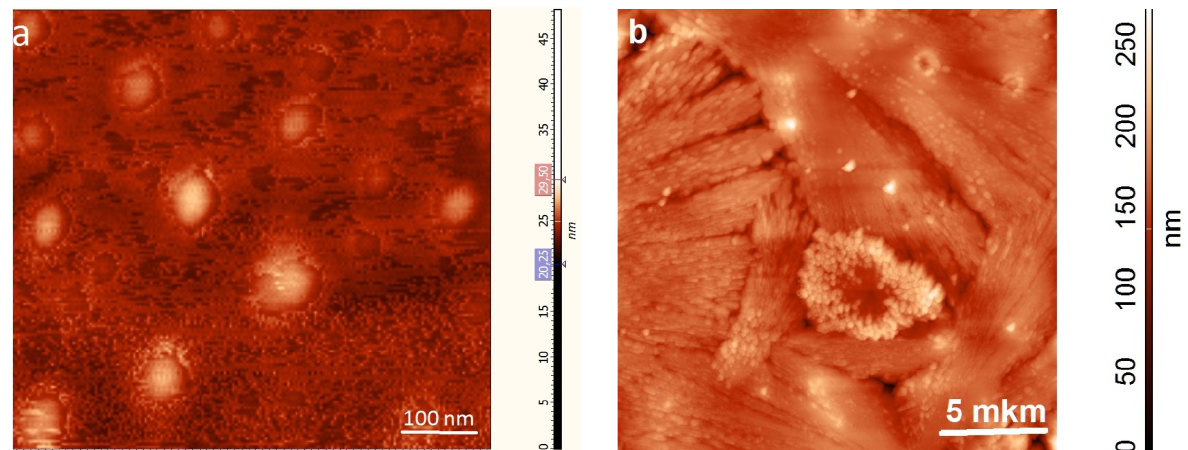
Fig. 3. AFM-STM images of ultra thin (a) and thin layers (b) of DPT-nAu on the surfaces of mica (a) and gold (b).